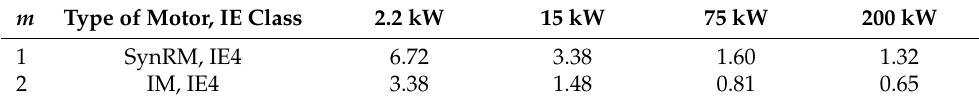
Table 8. Cost savings (avoided CO 2 emissions, in%) relative to the PDS with an IE3 motor. m